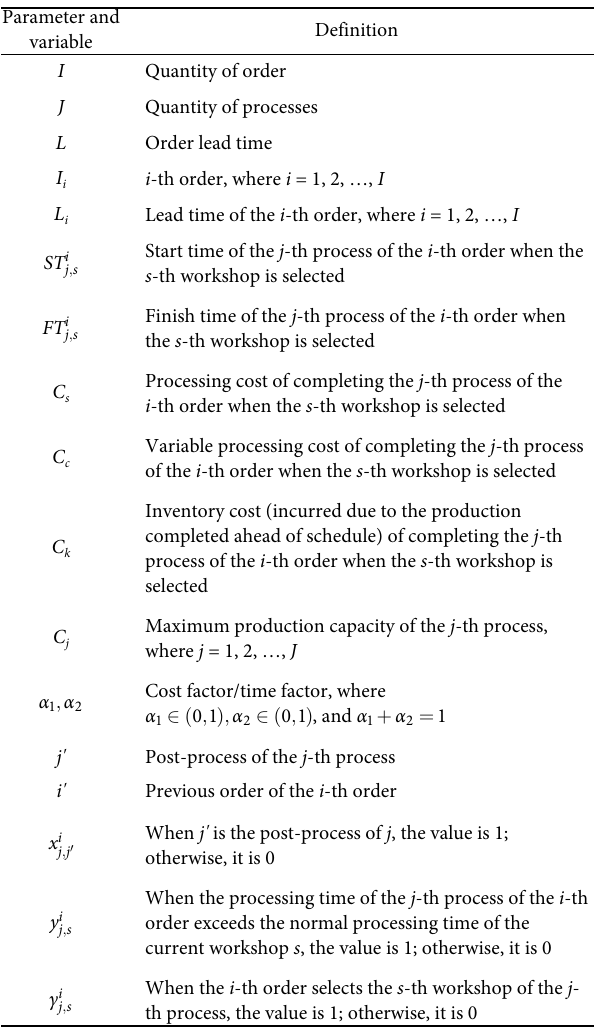
Table 1 Parameters and